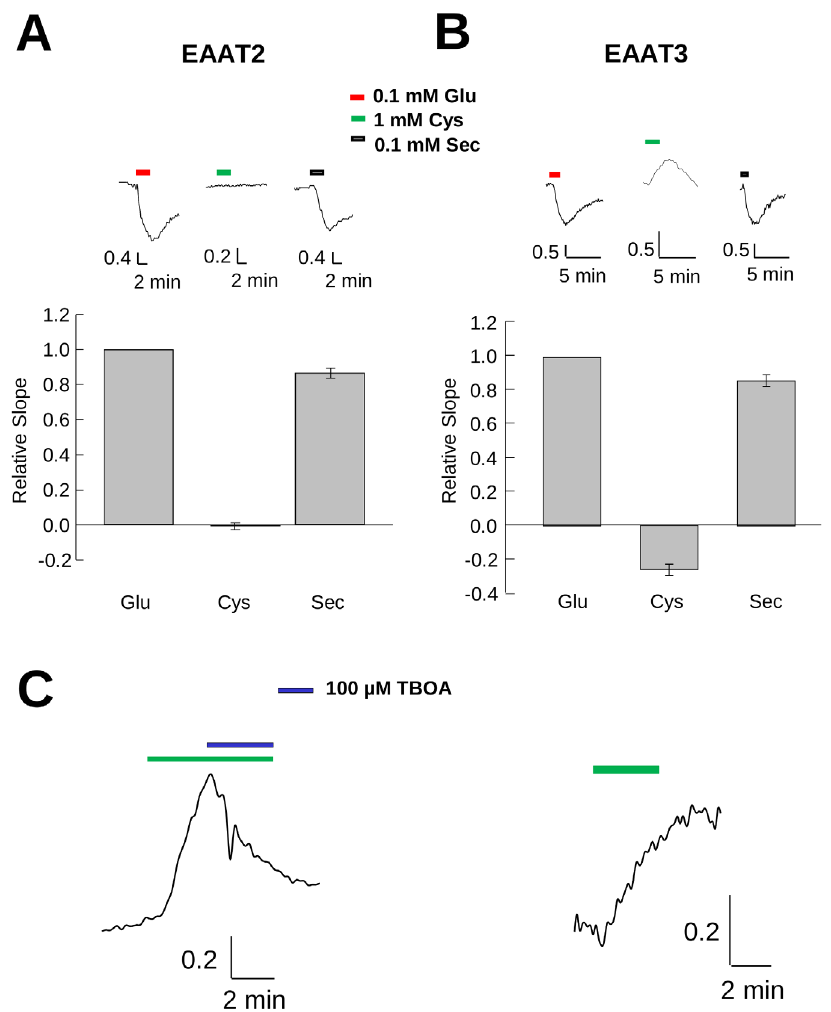
Figure 6. Transport of substrates in cells expressing EAAT2 or EAAT3 differentially affects intracellular pH. Representative fluorescence recordings from HEK293 cells expressing EAAT2 ( A ) or EAAT3 ( B ) in response to short applications of different concentrations of L- cysteine, L-glutamate or L-selenocysteine. The magnitude of maximal steady state slopes ( A and B ) are plotted in bar graphs below each trace, normalized to the glutamate slope magnitude. C) Representative trace of the effect on cysteine induced mEGFPpH fluorescence changes in EAAT3 expressing HEK293 cells with (left) or without (right) 100 m M TBOA. The Y-axis units for traces represent the fluorescence ratio for emission at 510 nm with excitation at 485 and 405 nm